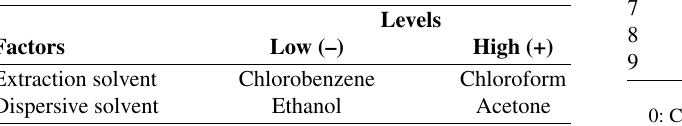
Table 1. The design variables, low and high levels in 2 2 full facto- rial design matrix